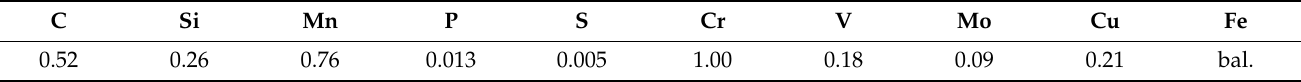
Table 1. Chemical composition of the studied 51CrV4 spring steel expressed in percent by weight.